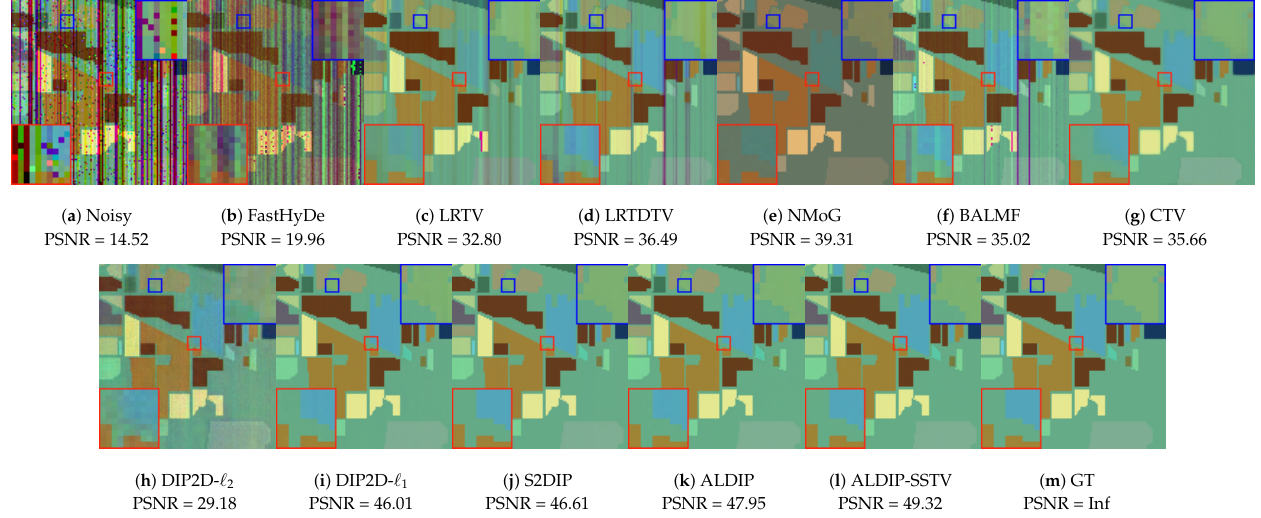
Figure 4. GT, Noisy and denoising result by methods for comparison on Indian Pines dataset (case 8). The pseudo images consisted of the 185th, 136th and 19th bands are selected to display. Two local areas (red and blue squares) are demarcated zoomed for easy observation.